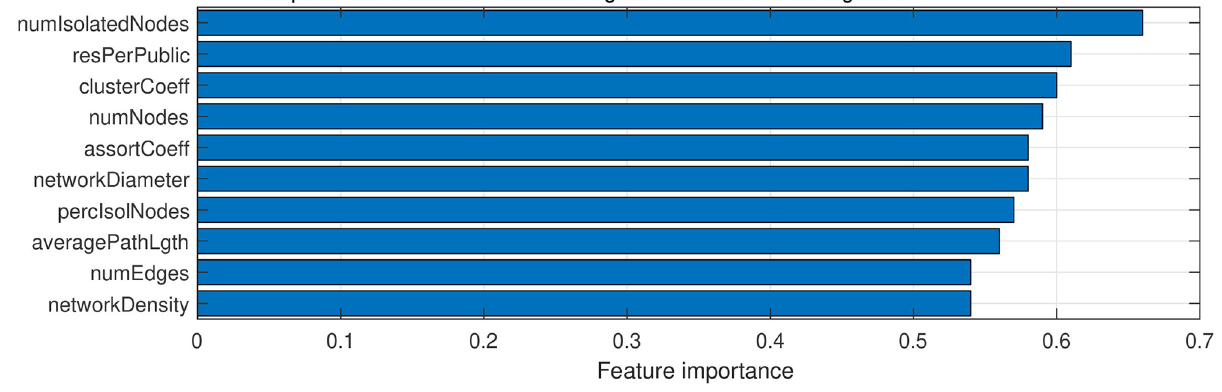
PLOS ONE | https://doi.org/10.1371/journal.pone.0261200 January 18,